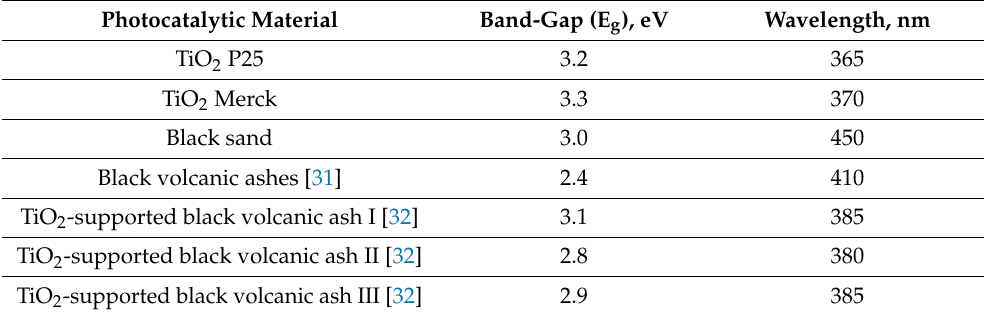
Table 2. Band-gap (eV) and wavelength (nm) of light activation for several photocatalytic Table 2. Band ‐ gap (eV) and wavelength (nm) of light activation for several photocatalytic materials.